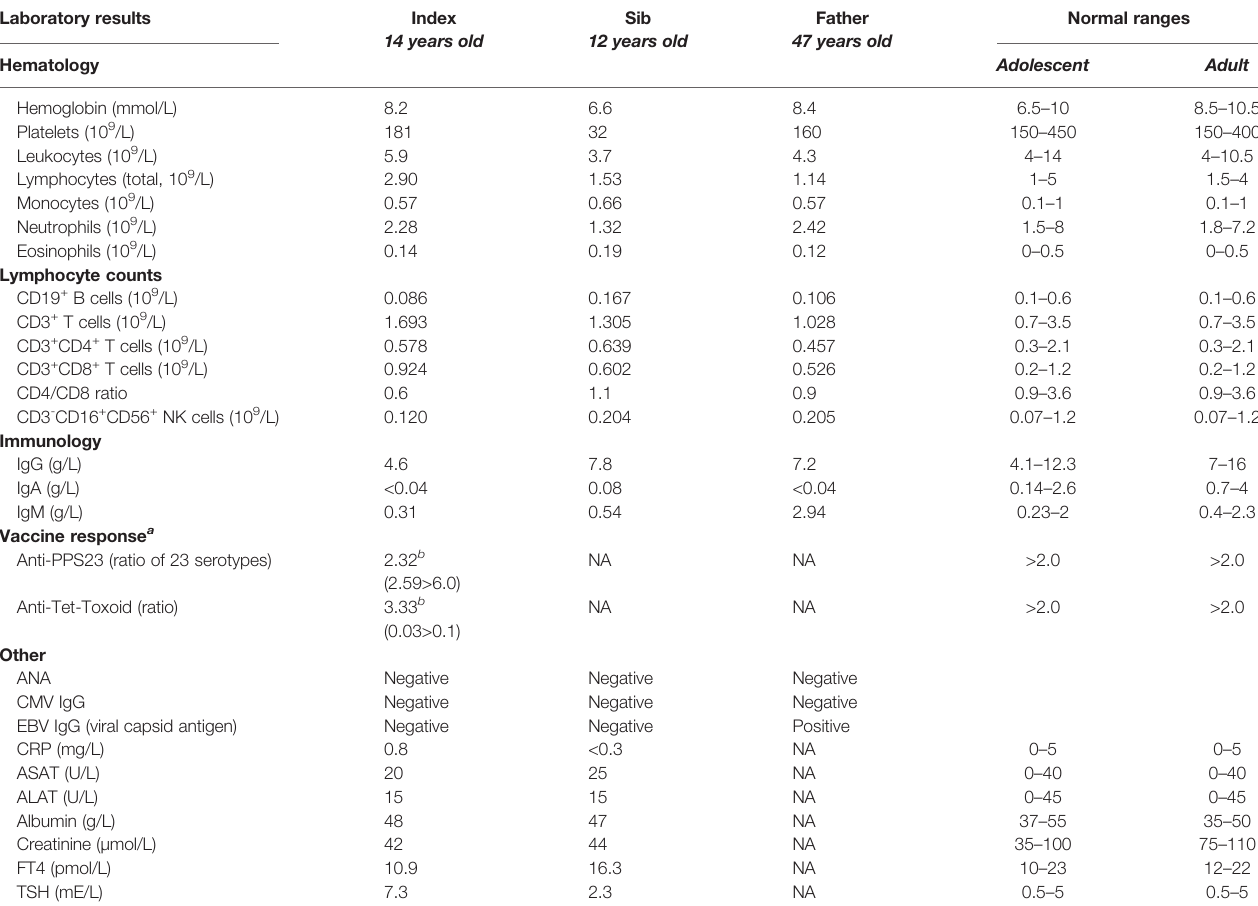
TABLE 1 | Hematology and immunology parameters in index, sib and father at